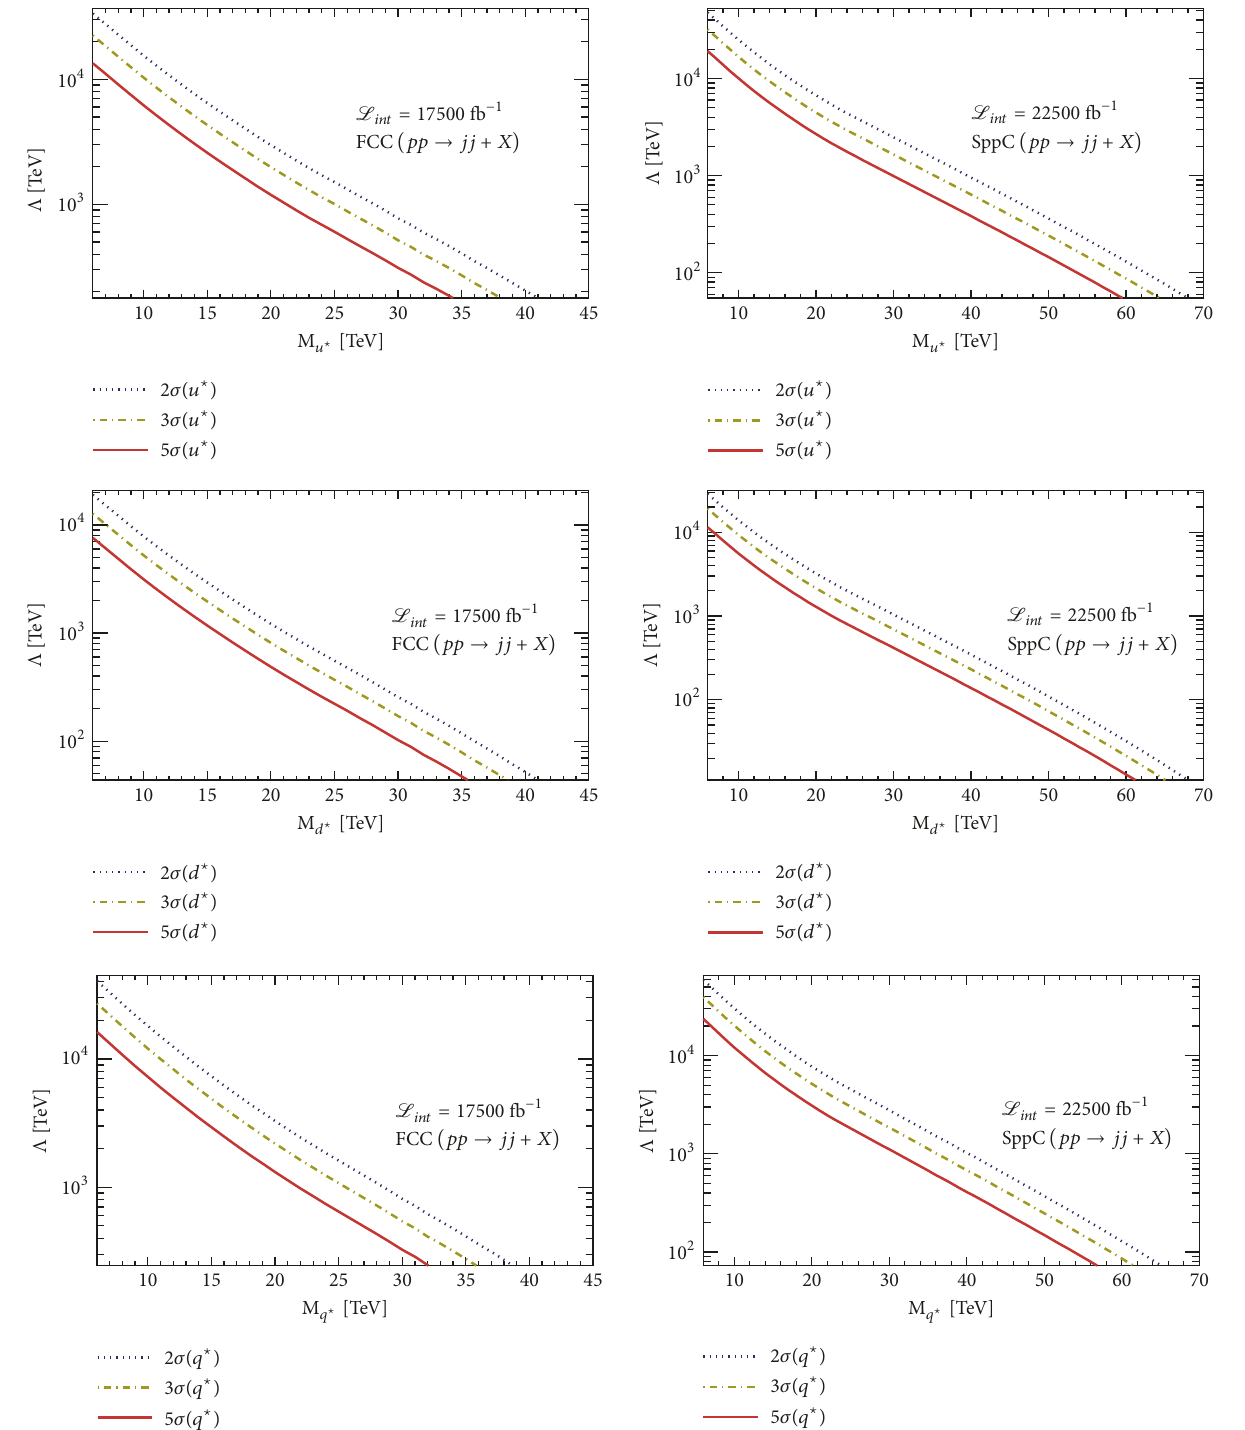
Figure 6: Compositeness scale dependence on 𝑢 ⋆ mass for the FCC (left column) and SppC (right column).